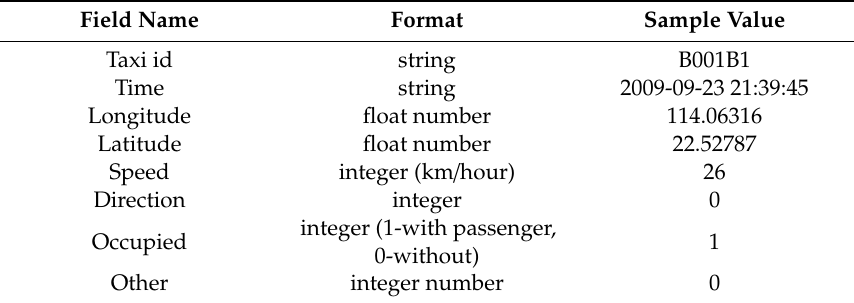
Table 2. Description for one record in the Shenzhen Taxi dataset.